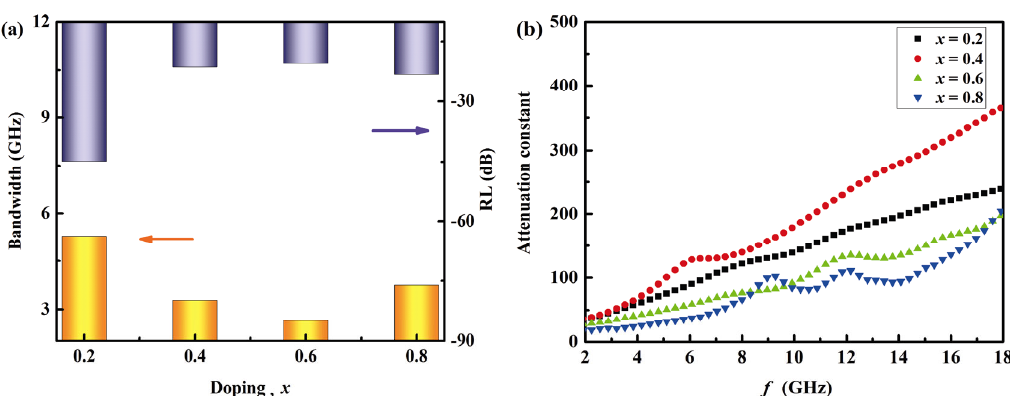
Fig. 7 (a) Maximum RL and the corresponding bandwidth over − 10 dB of each component and (b) attenuation constant of BFTO- x ceramics. Table 3 Maximum RL and corresponding bandwidth over − 10 dB of PVA-mixed BFTO- x ceramics Maximum Component Thickness (mm) RL